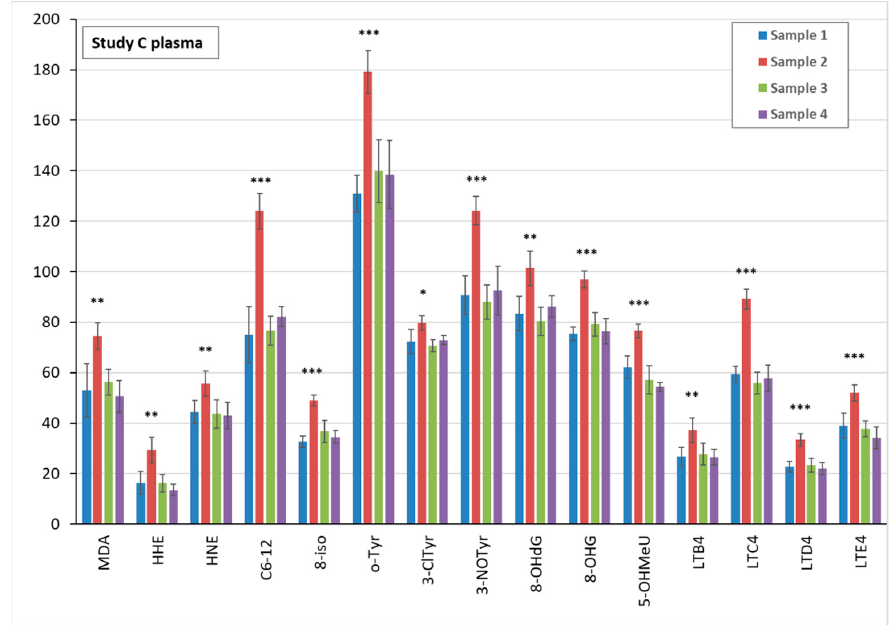
Figure 5. Comparison of the mean levels of oxidative stress and inflammatory markers in study C blood plasma pre-exposure (sample 1) and after both sunscreen and UV exposure (samples 2–4). * ( p < 0.05) ** ( p < 0.01) *** ( p < 0.001). MDA = malondialdehyde, HHE = 4-hydroxy- trans -hexenal, HNE = 4-hydroxy- trans -nonenal, C6-12 = aldehydes C6-C12, (all ng/mL); 8-iso = 8-isoProstaglandin F2 α , o-Tyr = o-tyrosine, 3-ClTyr = 3-chlorotyrosine, 3-NOTyr = 3-nitrotyrosine, 8-OHdG = 8-hydroxy-2- deoxyguanosine, 8-OHG = 8-hydroxyguanosine, 5-OHMeU = 5-hydroxymethyl uracil, and leukotrienes (LT) LTB4, LTC4, LTD4, LTE4 (all pg/mL).